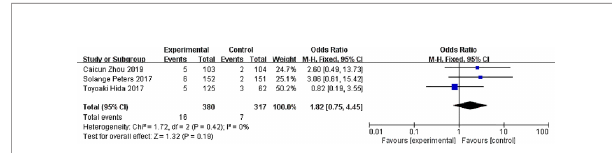
FIGURE 7 | Meta-analysis of complete response rate between alectinib group and crizotinib group.